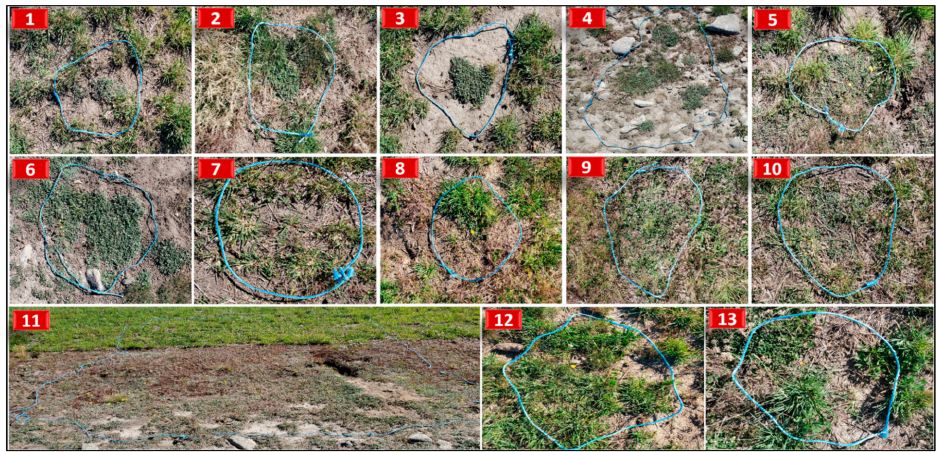
Figure 2. Images 1 to 13 show each of the sectioned areas used for ground truth data collection at the study